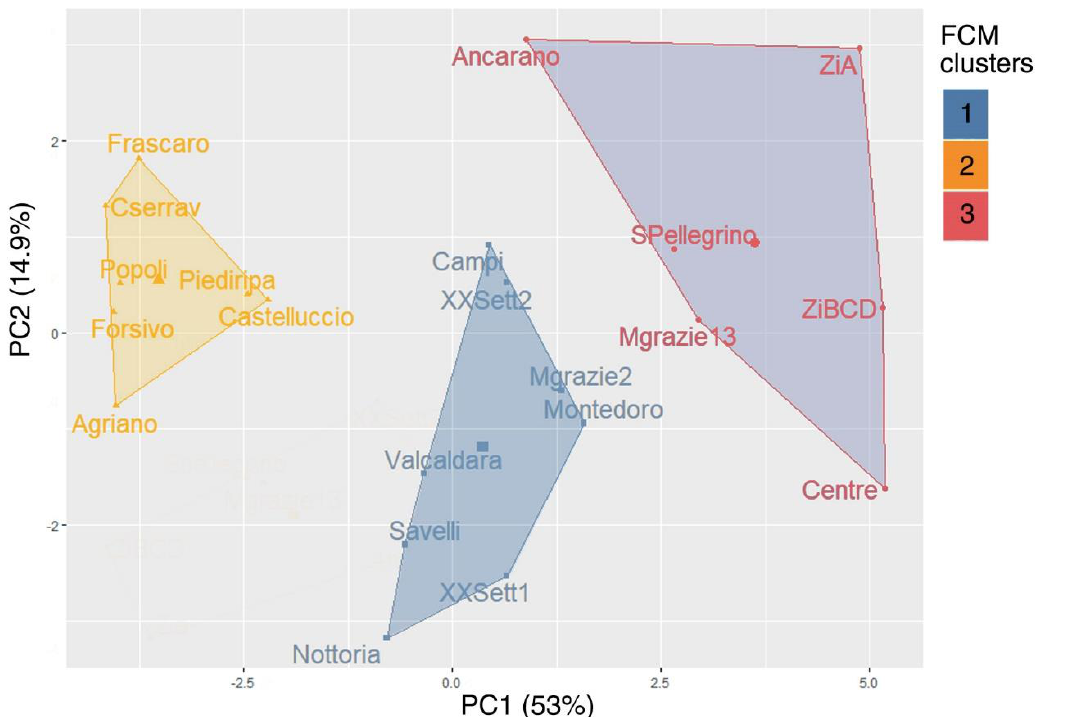
Figure 14 FCM VGA with city centre